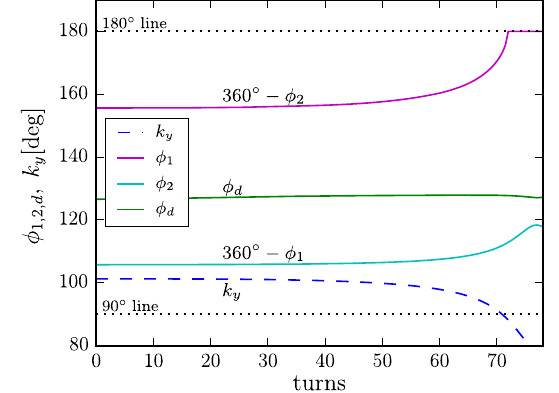
FIG. 11. Phase shifts of the envelope modes ϕ 1 dispersion mode ϕ numerically solved from the coupled d envelope approach during bunch compression.